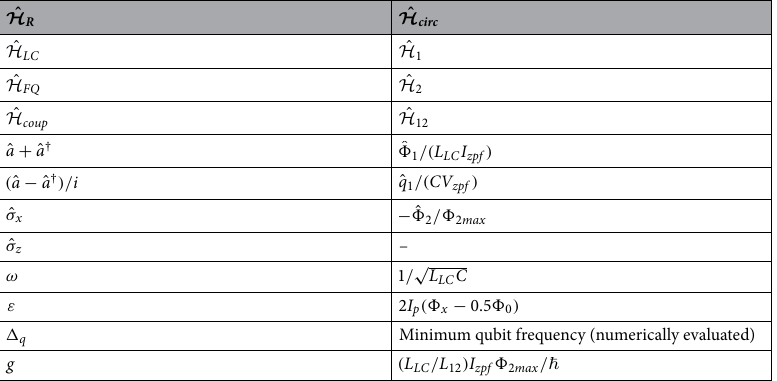
Table 1. Hamiltonians, operators, and variables in √ (cid:31) ω/( 2 C ) are the zero-point-fluctuation current and voltage, respectively. The parameters (cid:31) 2 max , and V zpf = I p , and (cid:31) q are obtained by numerically calculating the eigenenergies of lowest two energy levels by ˆ H FQ . Note that there is no analytic expression for